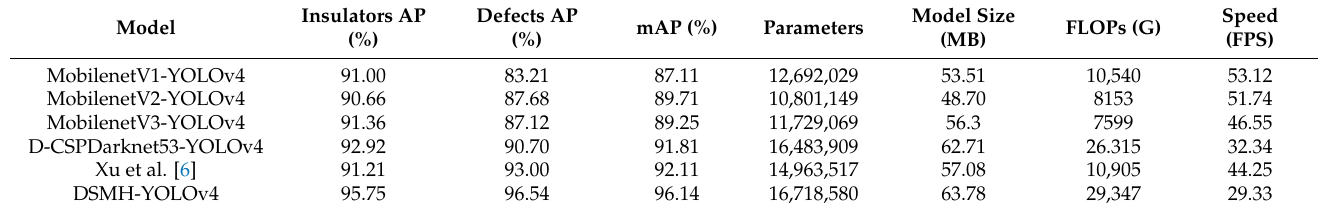
Table 2. Comparison of evaluation indicators of mainstream lightweight YOLOv4 network. Model